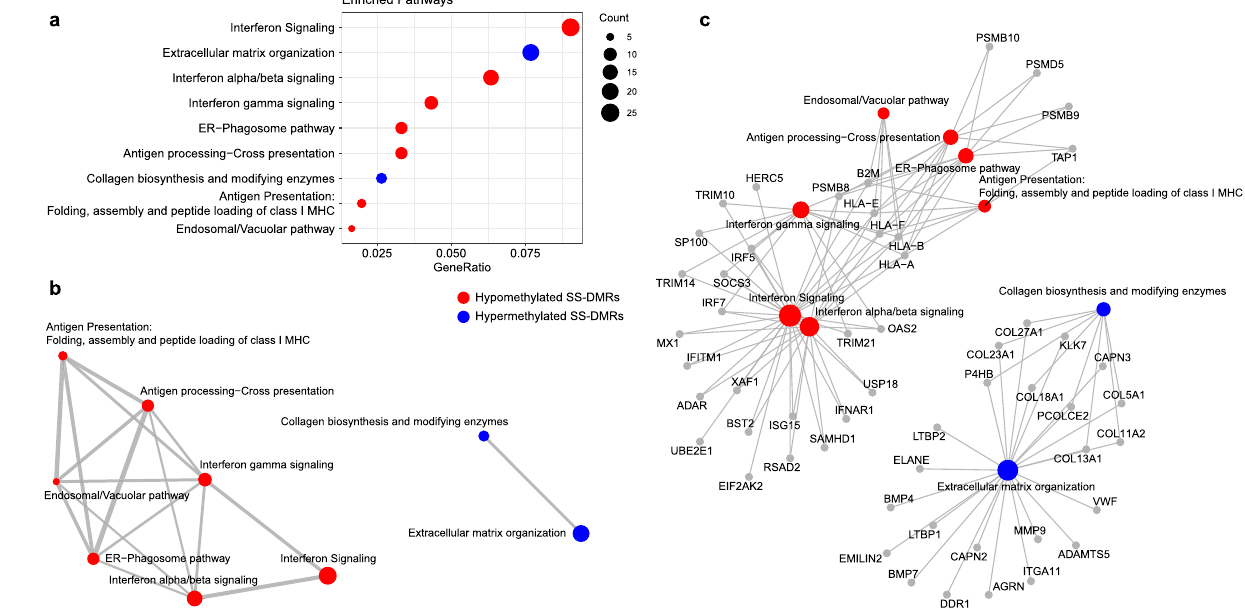
Figure 3. Functional Enrichment Results for differentially methylated regions based in Reactome database. ( a ) Dotplot representing Reactome functional pathways that are enriched in differentially methylated regions. Only significant pathways (adjusted P < 0.05) that are represented by more than 5 genes are illustrated. ( b ) Enrichment map that organizes significant enriched terms into a network with edges connecting overlapping gene sets. (c) Genes that are involved in significant terms are connected by linkages. Pathways in red are enriched in hypomethylated genes while pathways in blue are enriched in hypermethylated genes. Dot size represents number of genes with DMRs per pathways. R software 73 and Adobe Illustrator (https:// www. adobe. com/) was used to create